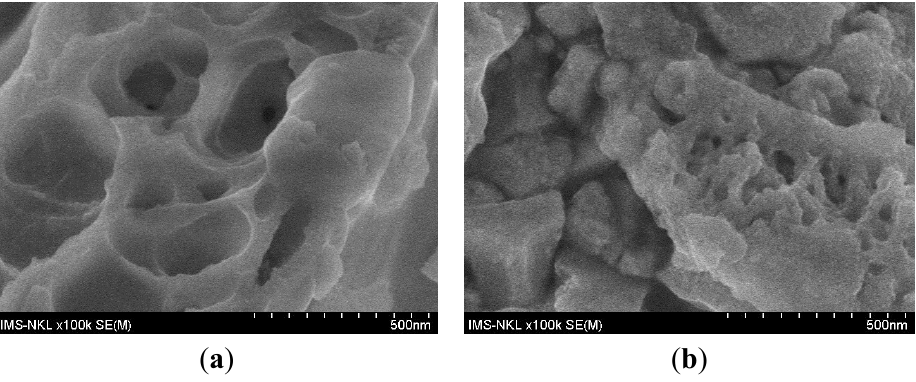
Figure 4. SEM images of Ce 0.8 Zr 0.2 O 2 sol-gel sample ( a ) before and ( b ) after